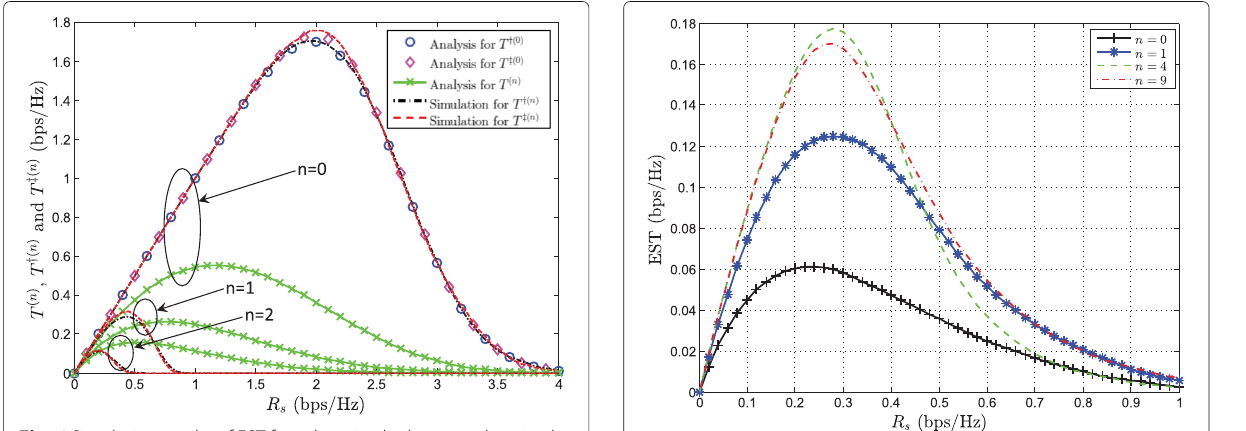
performance under an arbitrary SIC order by deriving the closed-form expressions of the secrecy outage